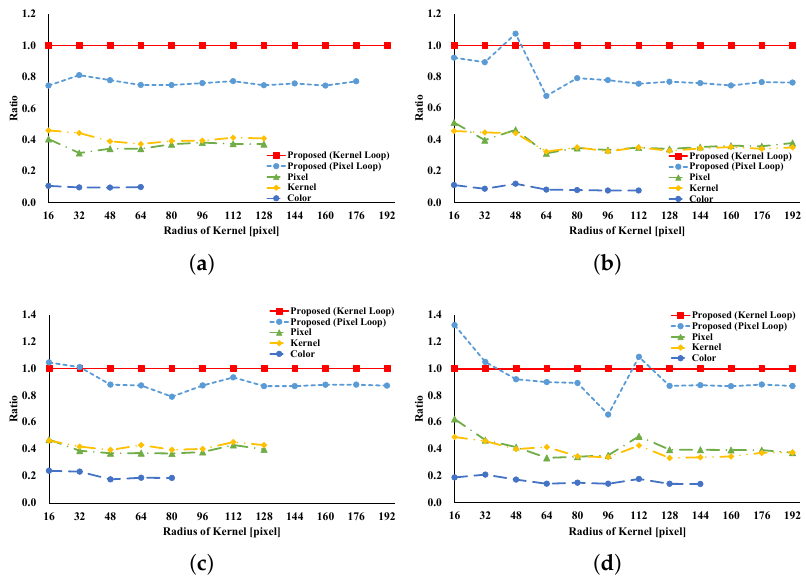
Figure 17. The speedup ratio of randomly-kernel-subsampled bilateral filtering (RKS-BF) with respect to the kernel radius of FIR filtering. ( a ) 1/4 subsample in weight computation; ( b ) 1/16 subsample in weight computation; ( c ) 1/4 subsample in LUT; ( d ) 1/16 subsample in LUT. If the ratio exceeds 1, the given pattern is faster than kernel loop